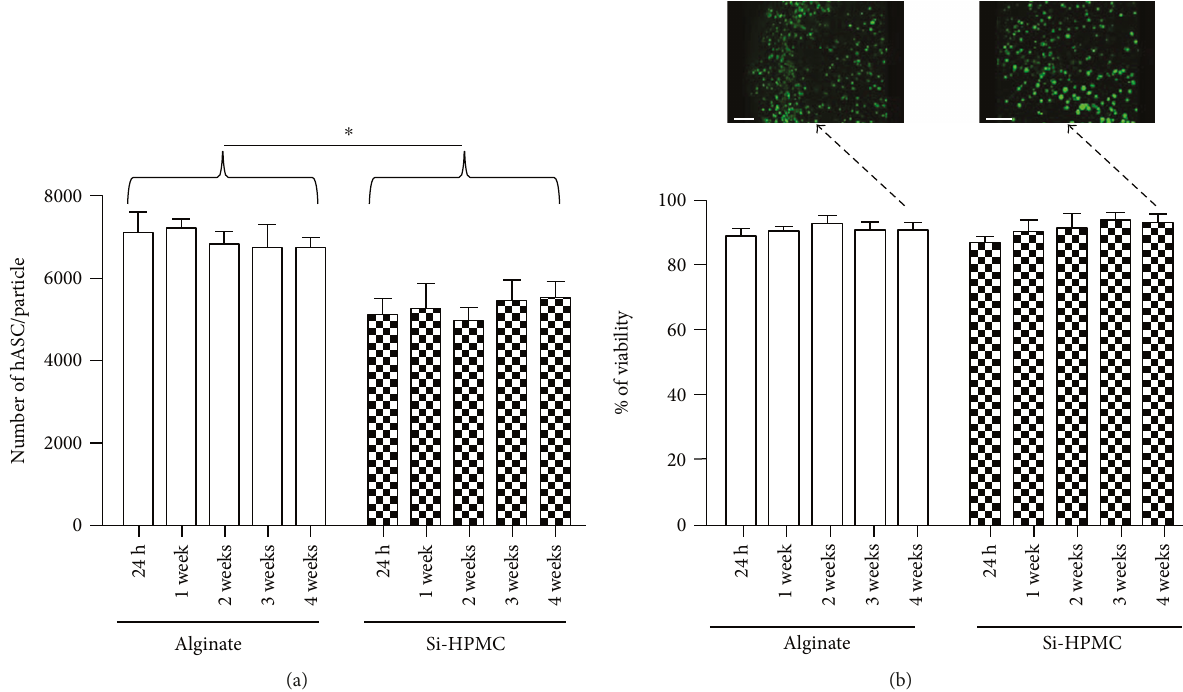
Figure 4: hASC viability after encapsulation in alginate and Si-HPMC. The average number of encapsulated hASC per alginate and Si-HPMC particles was evaluated from 24h to 1 month. (a) Average number of cells per particle. Alginate particles were dissolved in sodium citrate solution, and Si-HPMC particles were disrupted by ultrasonication. A DNA quanti fi cation by PicoGreen has allowed us to estimate the cell number. (b) Cell viability. Using a Live/Dead Viability/Cytotoxicity kit, cells encapsulated in alginate and Si-HPMC particle were assessed from 24h to 1 month of culture. Viable cells were imaged using a confocal microscope, and viability was calculated with Volocity software. Scale bars =100 μ m. ∗ p < 0 05